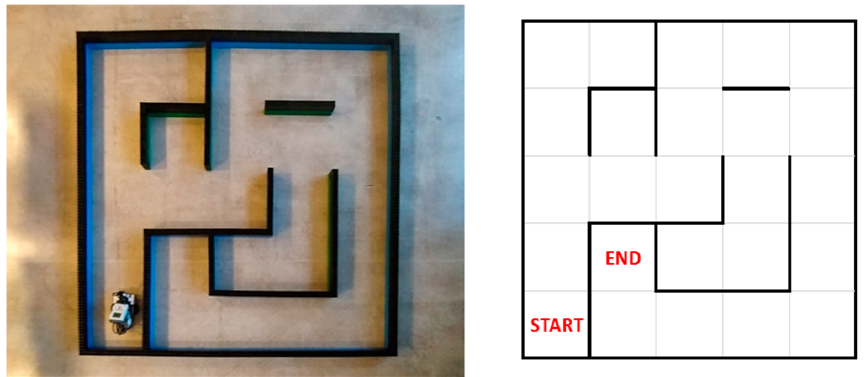
Figure 1. The maze was constructed using children’s kits; the scheme of the maze.